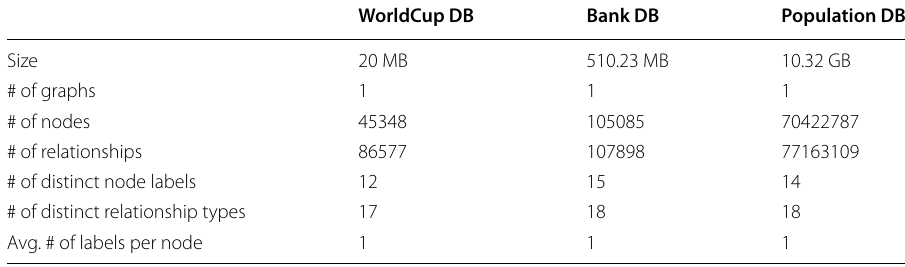
Table 1 General Features of Population, Bank and WorldCup